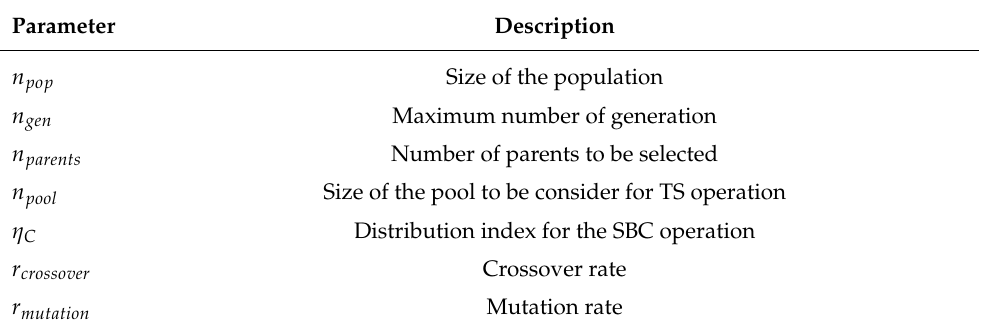
Table 3. The basic GA main parameters and their